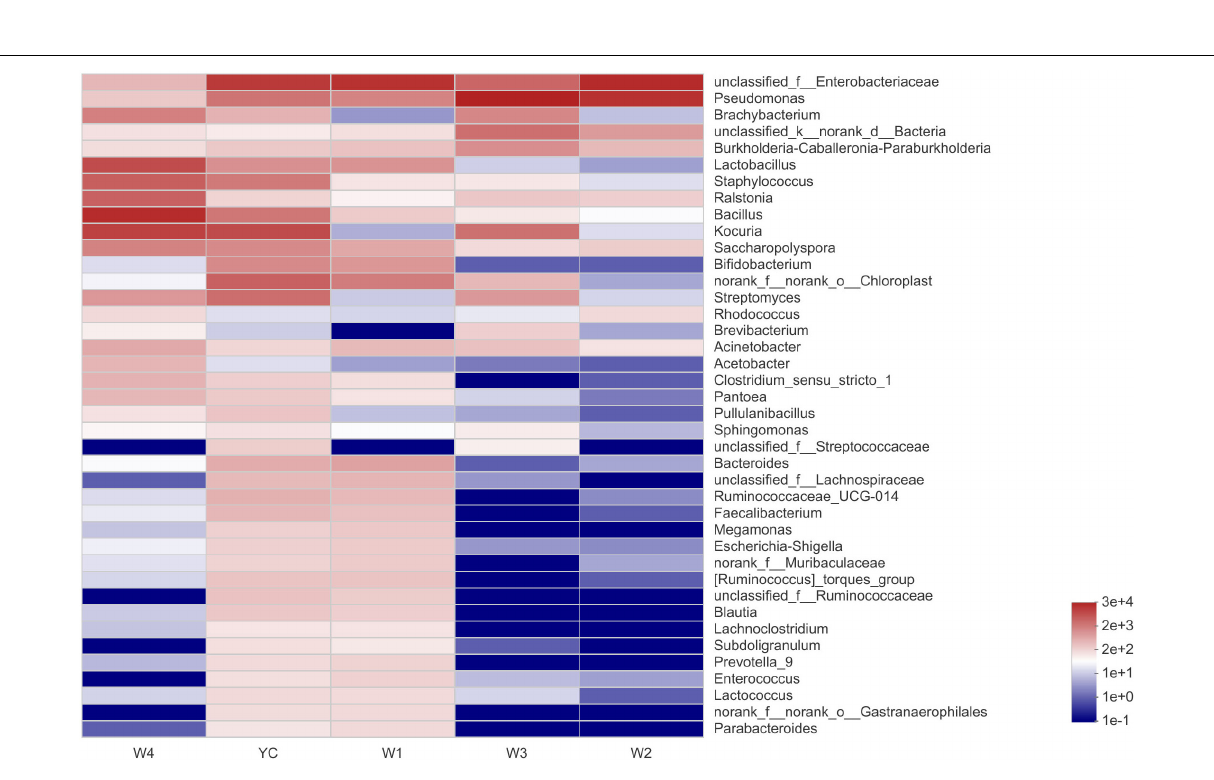
FIGURE 3 | Bacterial community structure bar plot analysis at the genus level. The ordinate is the sample name, and the abscissa is the proportion of different taxa at the genus level in a sample. Different taxa are represented by columns with different colors, sizes, and proportion of species.